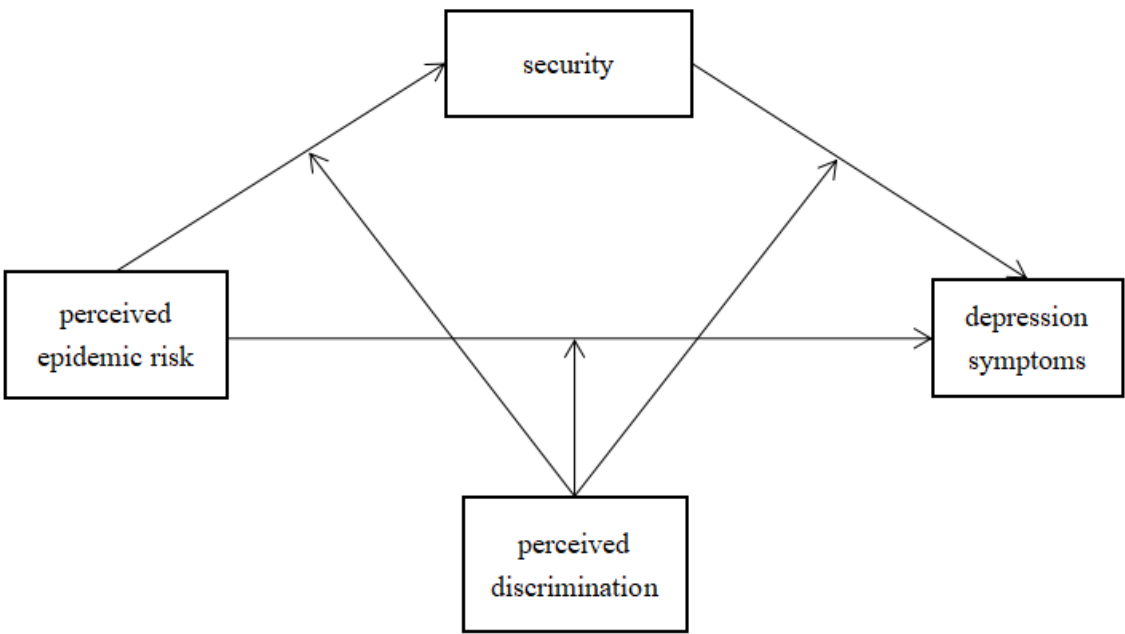
Figure 1. The proposed moderated mediation